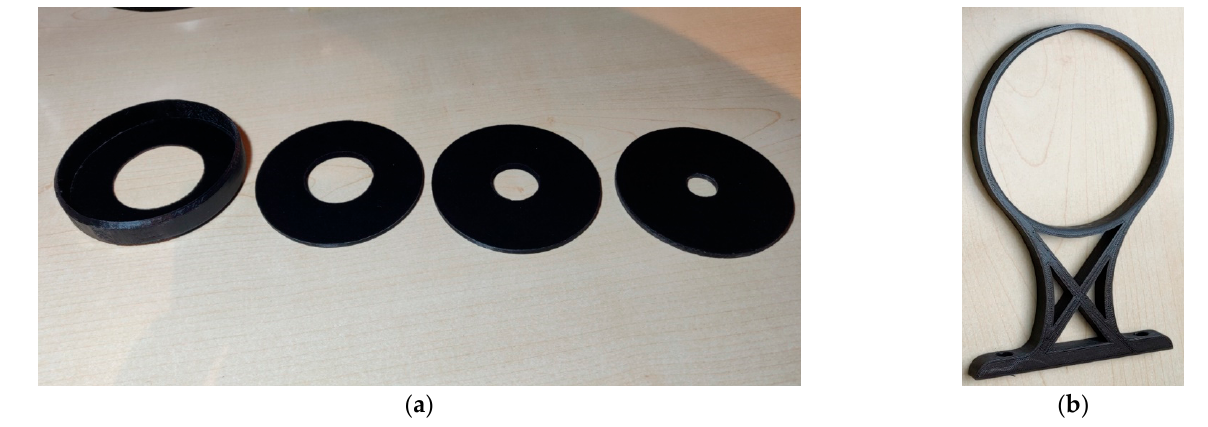
Figure 4. ( a ) Tunnel apertures with progressive inner openings diameters; ( b ) Tunnel supporting leg.